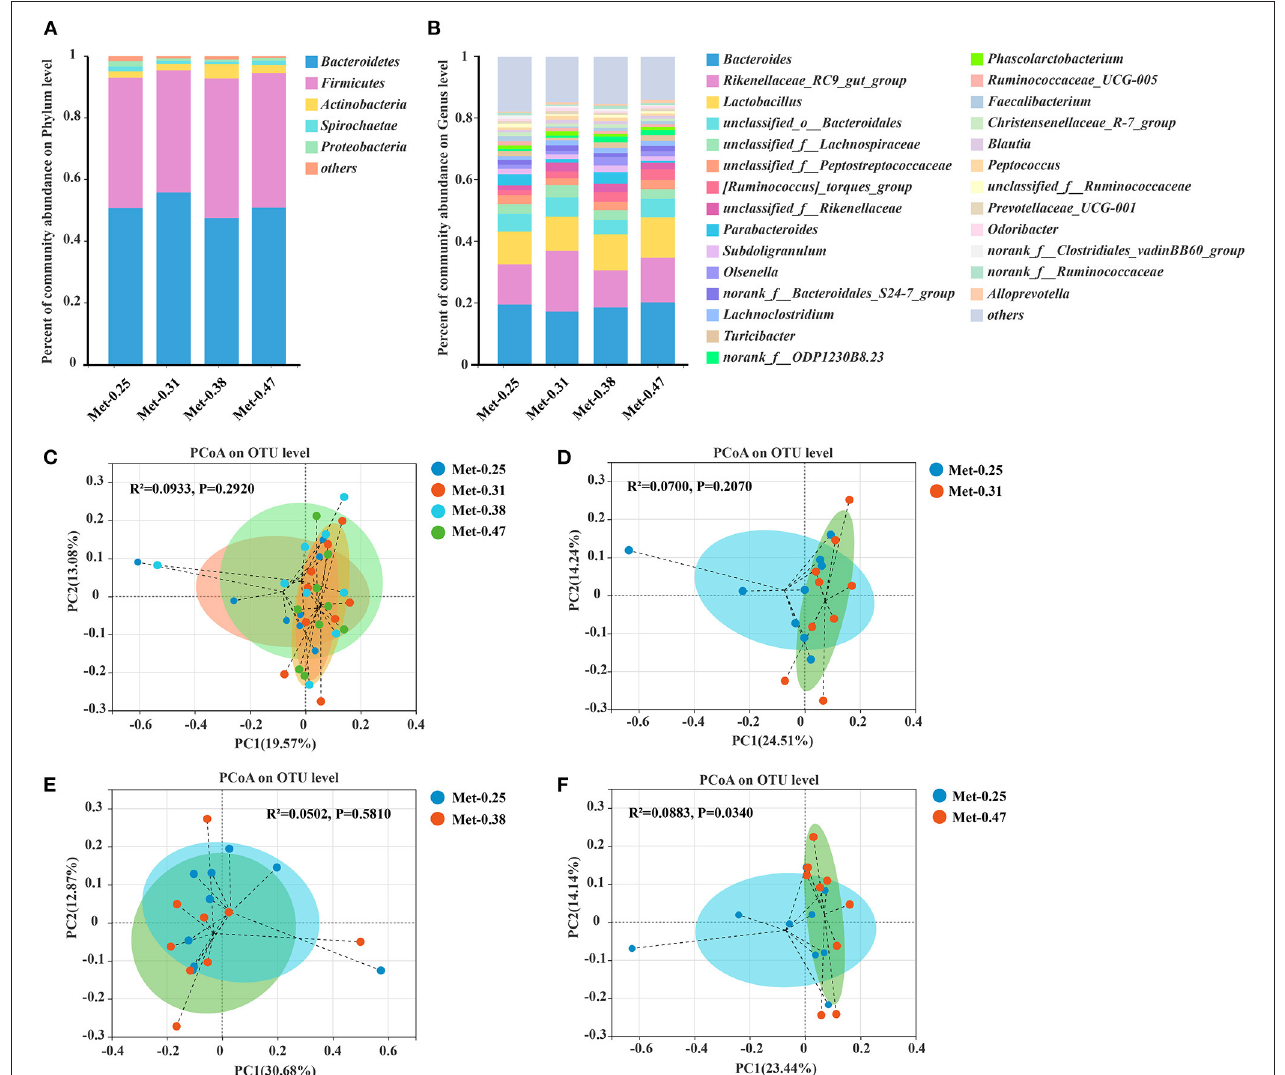
FIGURE 2 | The effects of different dietary Met supplementation in low protein diets on the relative abundance in the cecal microbiota of laying hens and the principal coordinate analysis (PCoA) (Bray–Curtis distance) plot of the gut microbial community structure between the 0.25% Met group, 0.31% Met group, 0.38% Met group, and 0.47% Met group ( n = 9 per group). (A) Relative abundance of gut microbiota at the phylum level ( n = 9 per group). (B) Relative abundance of gut microbiota at the genus level ( n = 9 per group). (C) The PCoA in the four treatments. (D) The PCoA in the 0.25 and 0.31% Met groups. (E) The PCoA in the 0.25 and 0.38% Met groups. (F) The PCoA in the 0.25 and 0.47% Met